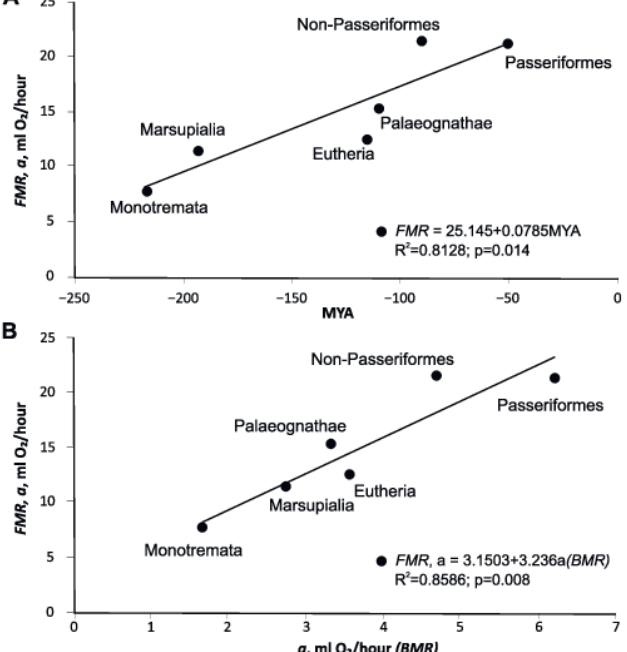
Figure 6. ( A ) The average FMR in the six major groups of endothermic animals depending on the geological time of appearance of the group in evolution. Regression lines and statistics in the figure are calculated using OLS method. ( B ) Relationship between FMR and BMR in the six major groups of endothermic animals. MYA—million years